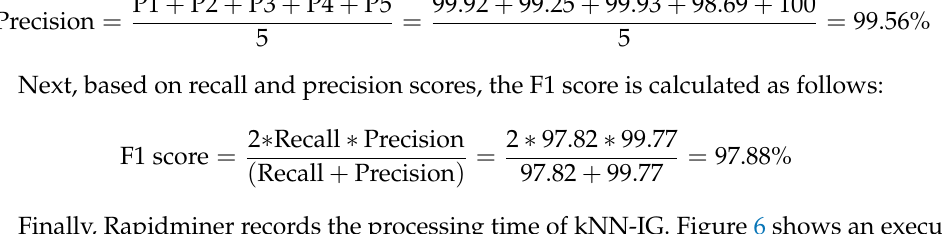
Figure 6. Execution time for kNN-IG.